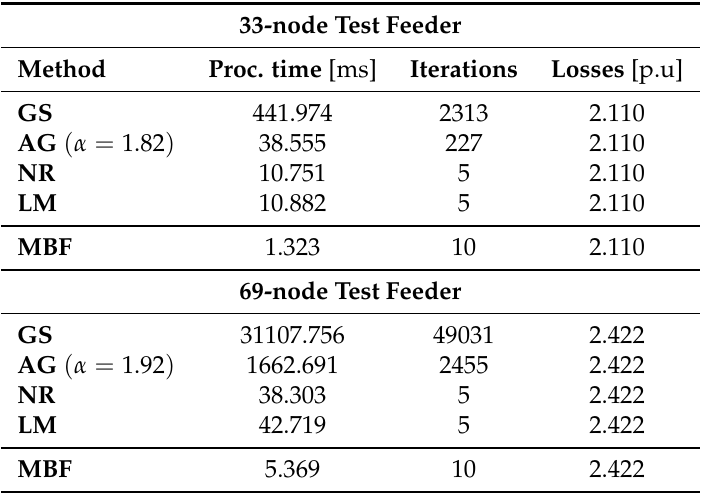
Table 5. Numerical results for the 33- and 69-node test systems. 33-node Test